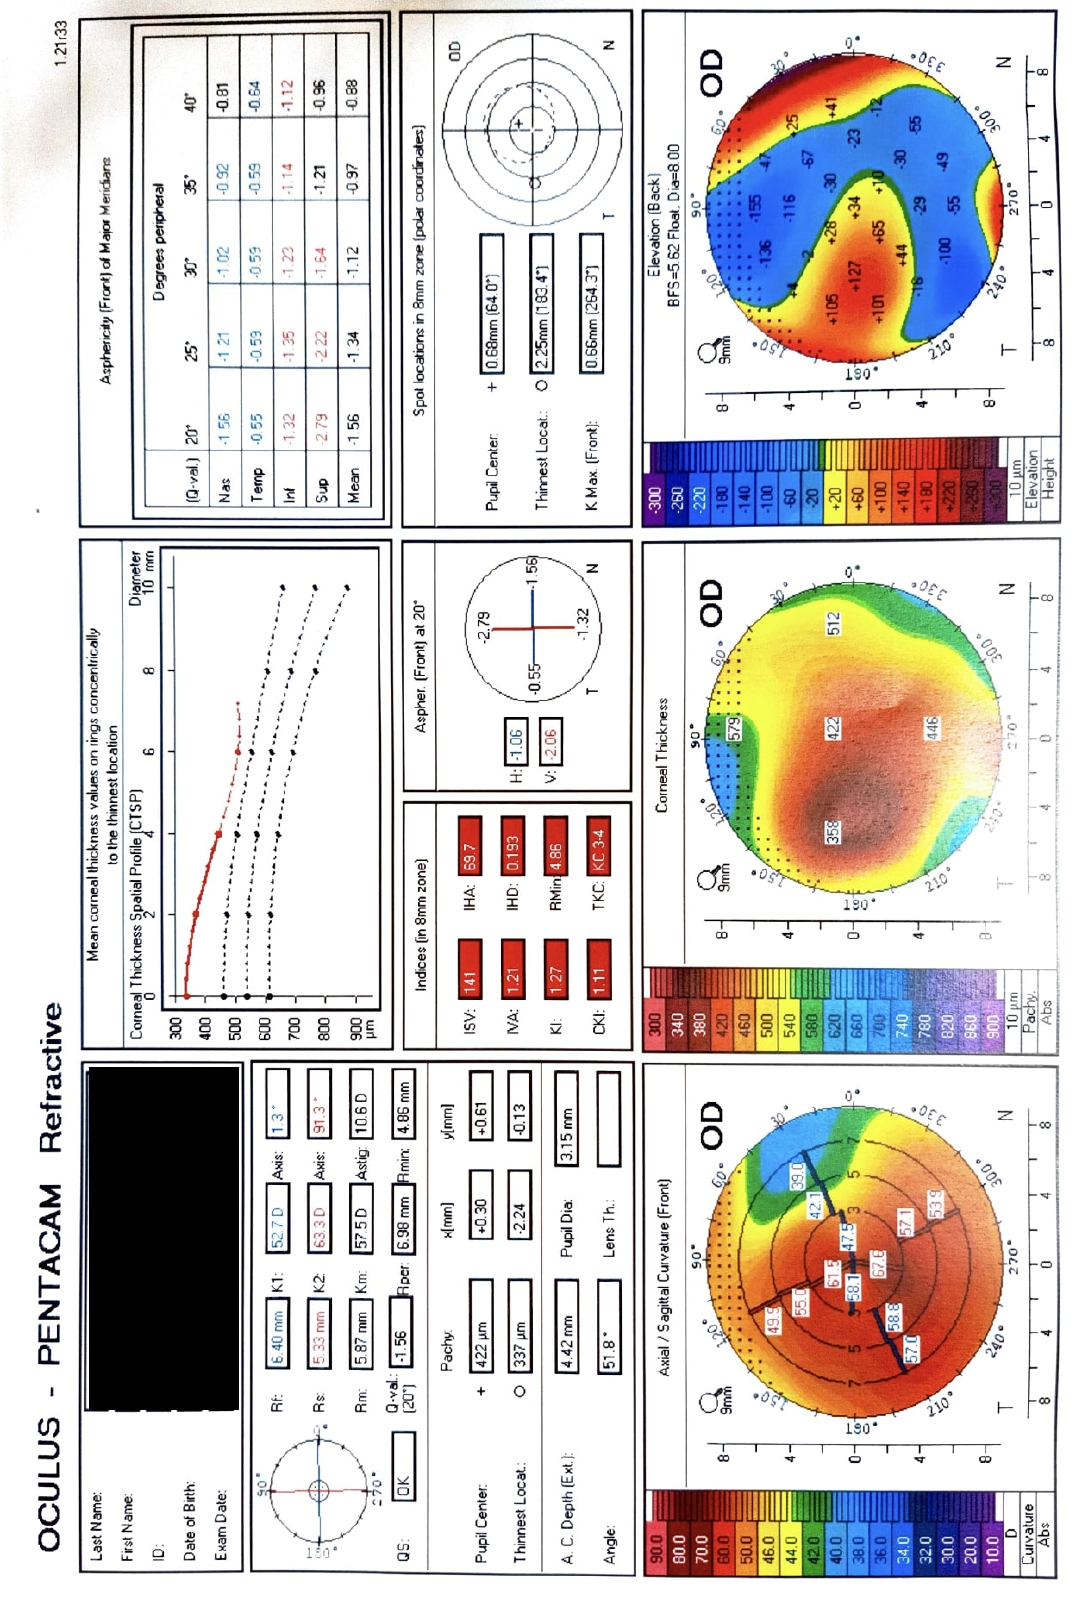
Figure 2: Image of the pentacam of the patient’s right eye depicting elevated K1 and K2 reading, thinnest pachymentry of 337 μm, paracentral and mild inferior steepening, anterior and posterior float elevation, altered indices and corneal thickness spatial profile suggestive of advanced keratoconus